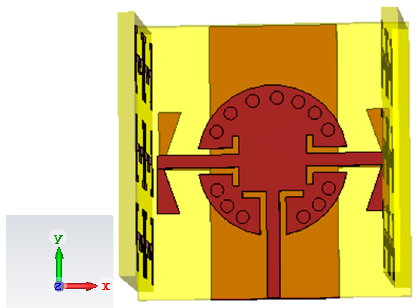
Figure 8. Antenna array configuration, including ENZ metamaterial slabs.